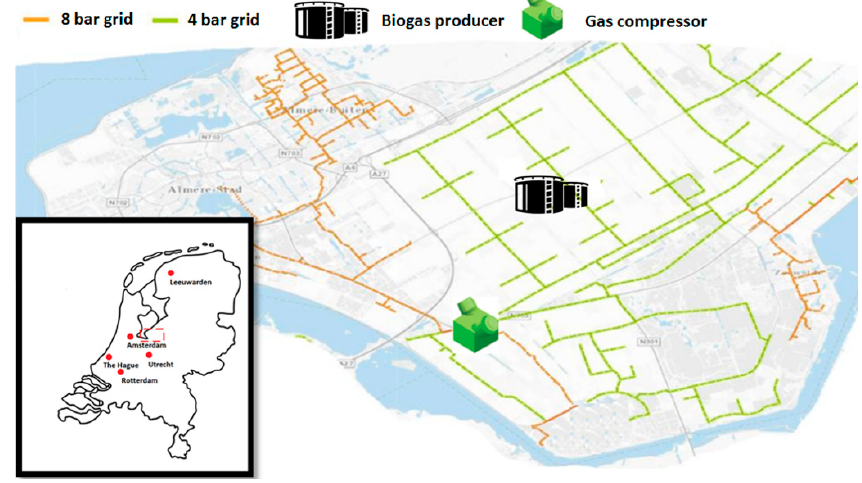
Figure 4. Gas compressor connecting the 4 and 8 bar gas grid, adapted from Reference [43].